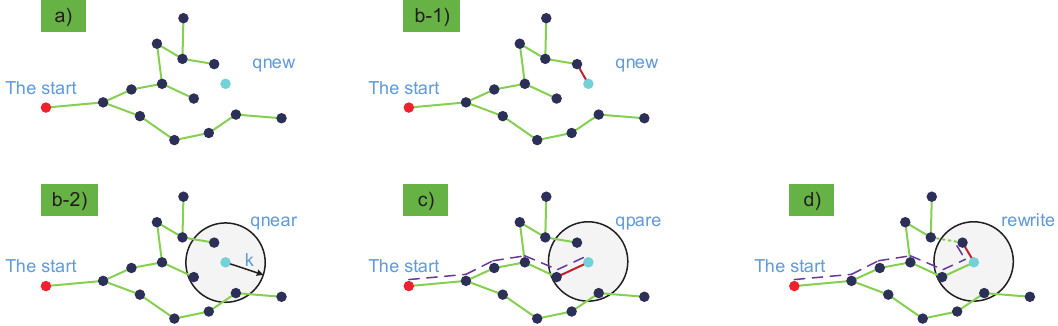
Figure 3. Illustration of the rapidly-exploring random tree (RRT) and RRT* algorithms. RRT consists of operations ( a , b-1 ). RRT* consists of operations ( a , b-2 , c , d ). ( a ) qnew denotes a new selected random node, the blue node. ( b-1 ) Node qnew is connect to its nearest node in the rapidly-exploring random tree. ( b-2 ) qnear denotes the near node set, as shown by the grey circular area. ( c ) qnew is connected to its qpare node which has the shortest route to the start (shown as the dotted path). ( d ) The remaining nodes in the grey circular area are rewired through qnew, if it provides the shortest path towards the